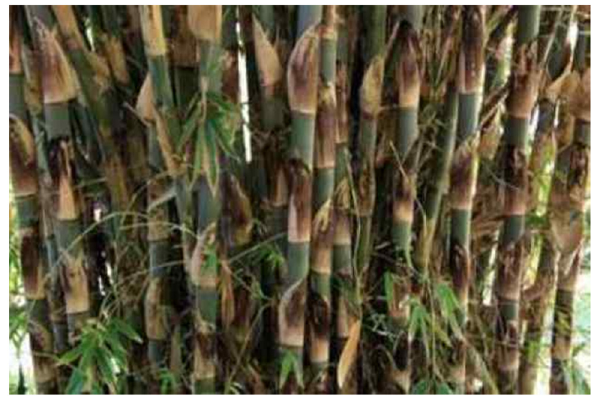
Figure 1: Apus bamboo ( Gigantochloa apus ) .